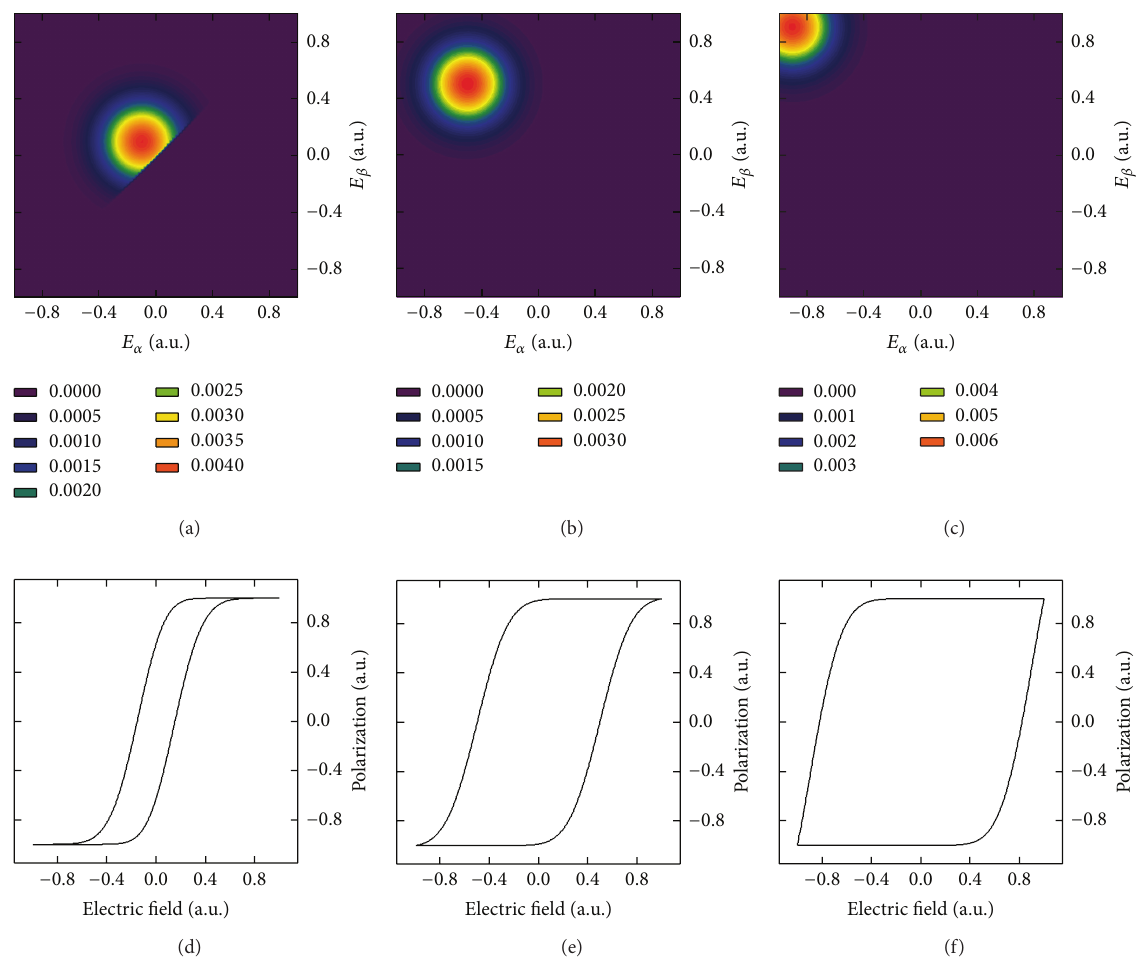
Figure 5: Gaussian-defined Preisach densities with 𝜎 = 0.20 and centers located at (a) 𝑦 0 = 0.10 , (b) 𝑦 0 = 0.50 , and (c) 𝑦 0 = 0.90 . Their associated hysteresis loops are shown in (d), (e), and (f), respectively.